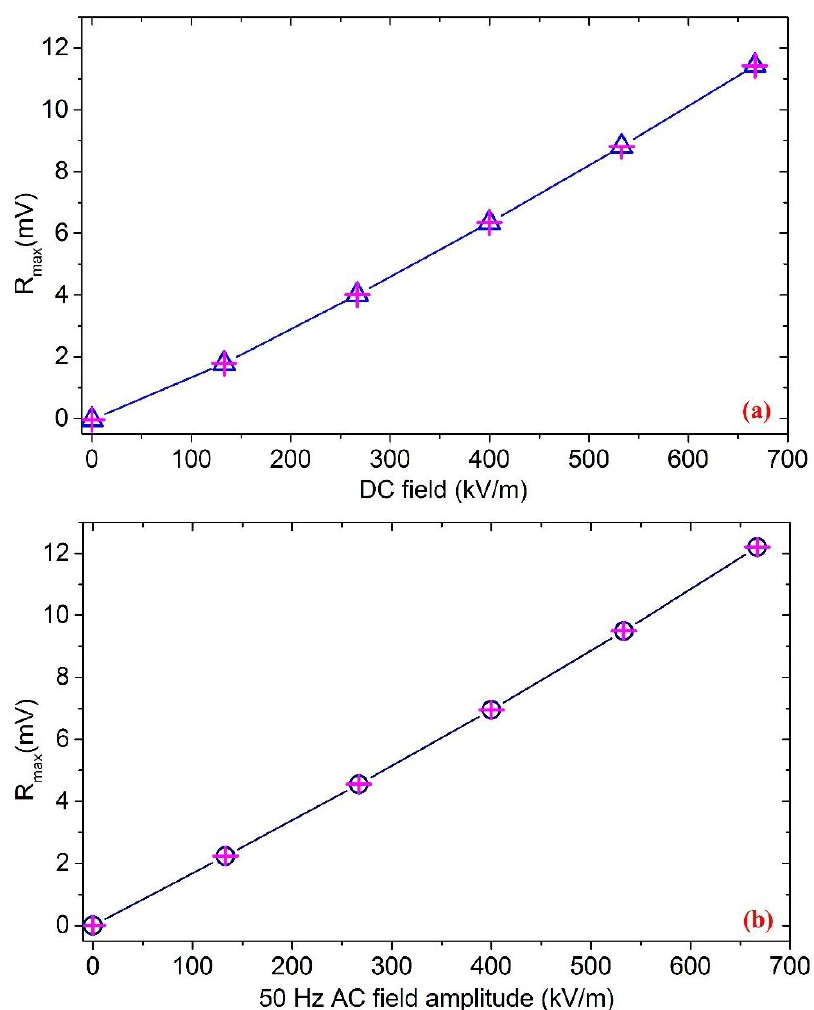
Figure 14. The response characteristics of the EFM: ( a ) The uncertainty of 2.4% for DC fields; ( b ) The uncertainty of 1.5% for 50 Hz power frequency fields. Table 1. The detailed test results of the response characteristics for DC fields.